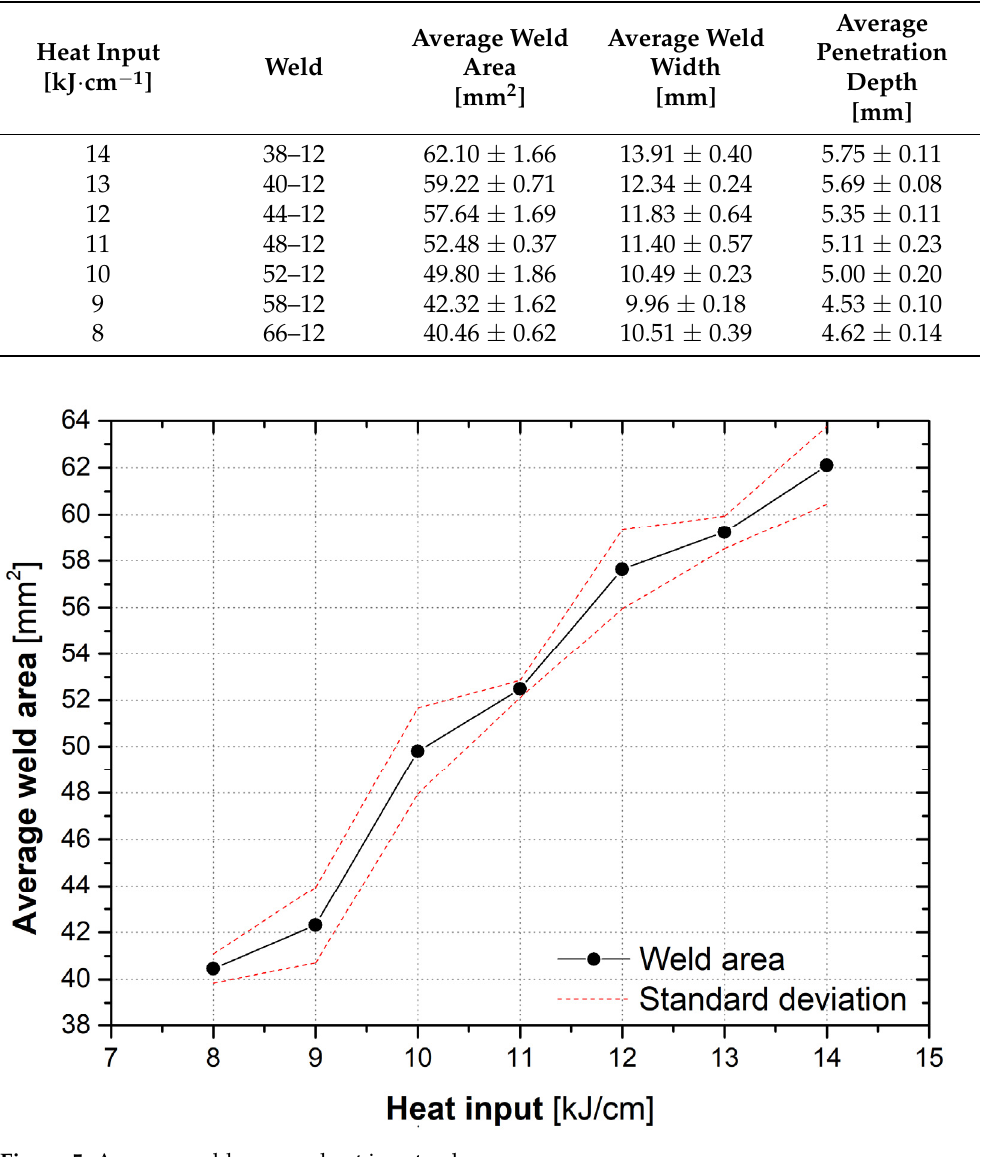
Figure 5. Average weld area vs. heat input values.